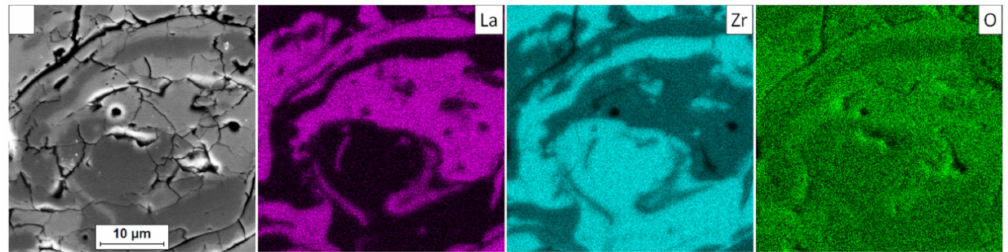
Figure 30. Element distribution in the area of the La 2 Zr 2 O 7 / 8YSZ